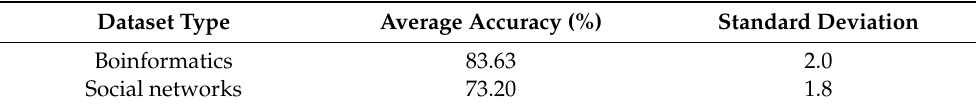
Table 4. Comparison on average performance on two classes of